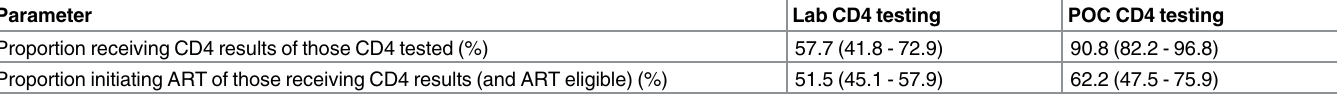
Table 1. Results of meta-analysis of CD4 staging for POC CD4 and laboratory testing (95% confidence intervals shown in brackets). Parameter Proportion receiving CD4 results of those CD4 tested (%) Proportion initiating ART of those receiving CD4 results (and ART eligible)